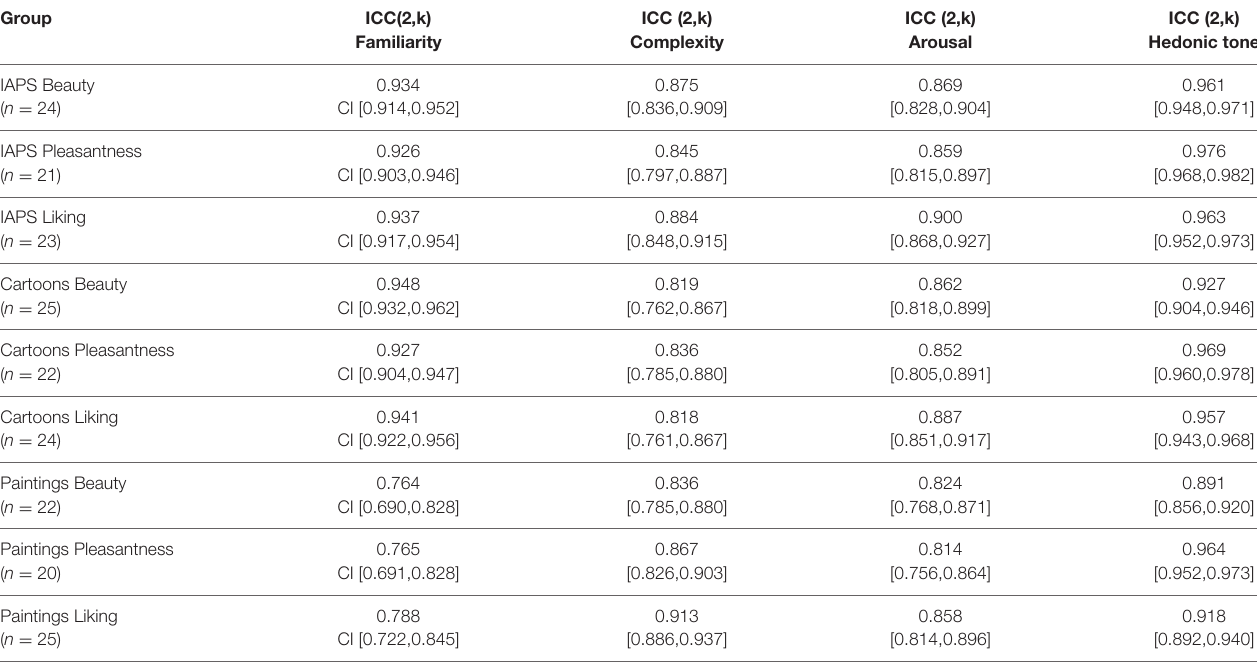
TABLE 2 | Intra-class correlation coefficients (ICCs) for subjective ratings of familiarity, complexity, arousal and hedonic tone (beauty, pleasantness and liking).